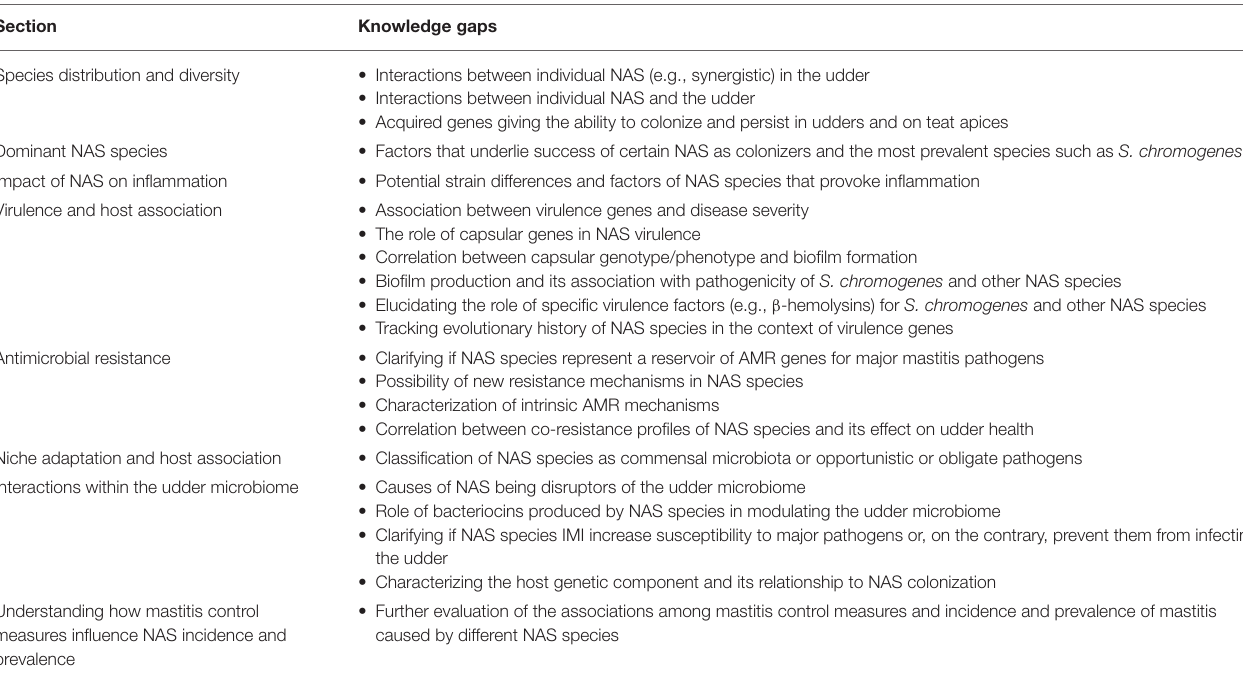
TABLE 1 | Knowledge gaps in understanding the role of NAS on udder